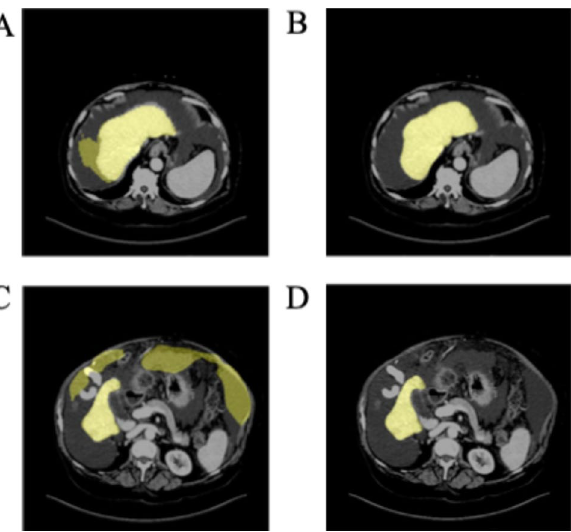
Figure 3. Example of PADLLS oversegmentation correction of ascites. ( A ) V-net liver segmentation with no ascites correction and ( C ) H-DenseUnet segmentation with no ascites correction. ( B ) and ( D ) are final pipeline segmentations with ascites correction. The yellow shading in all of the images demarcates the liver. Window width (WW) and window length (WL) of 30 and 150 HU were used,